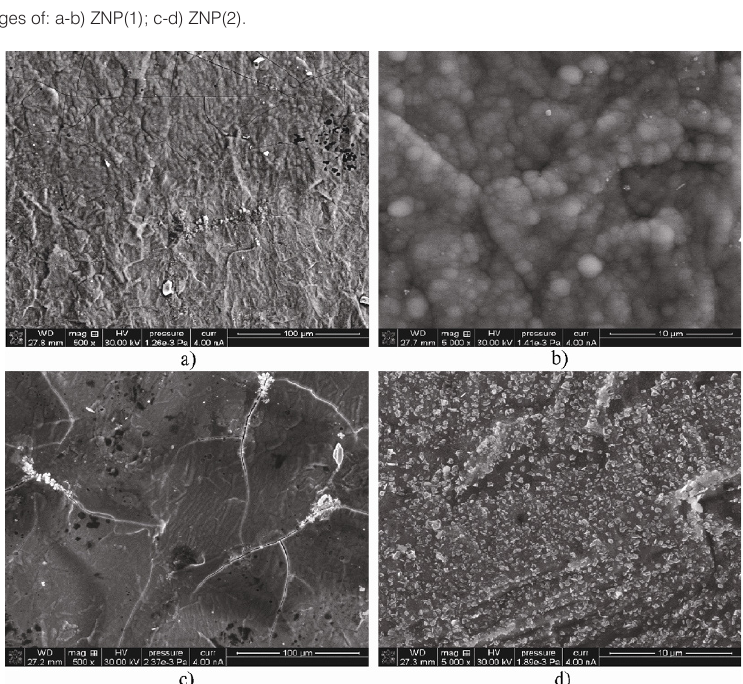
Figure 6. SEM images of: a-b) ZNP(3); c-d)